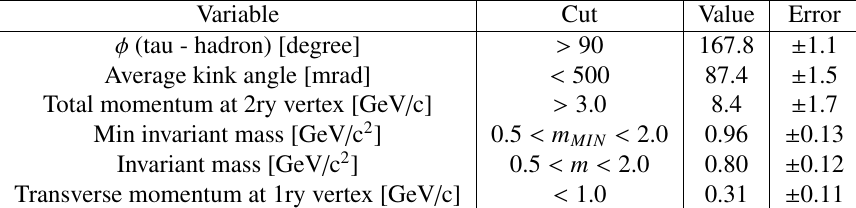
Table 2. Selection criteria for ν τ candidate definition and corresponding values measured for the second observed tau candidate